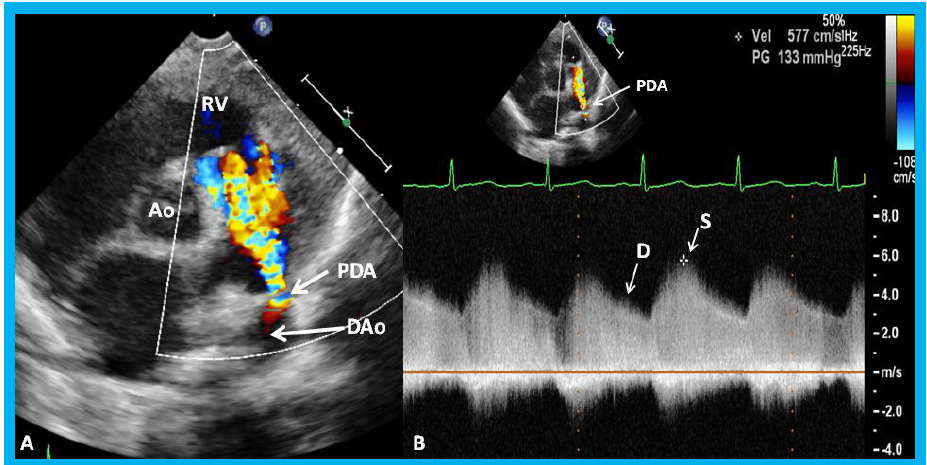
Figure 32. Parasternal short axis echo-Doppler imaging ( A ) demonstrating patent ductus arteriosus (PDA) with left-to-right shunt and high Doppler flow velocity ( B ) across the PDA suggestive of normal/low pulmonary artery pressure. Ao, aorta; D, diastolic; DAo, descending aorta; RV, right ventricle; S, systolic.